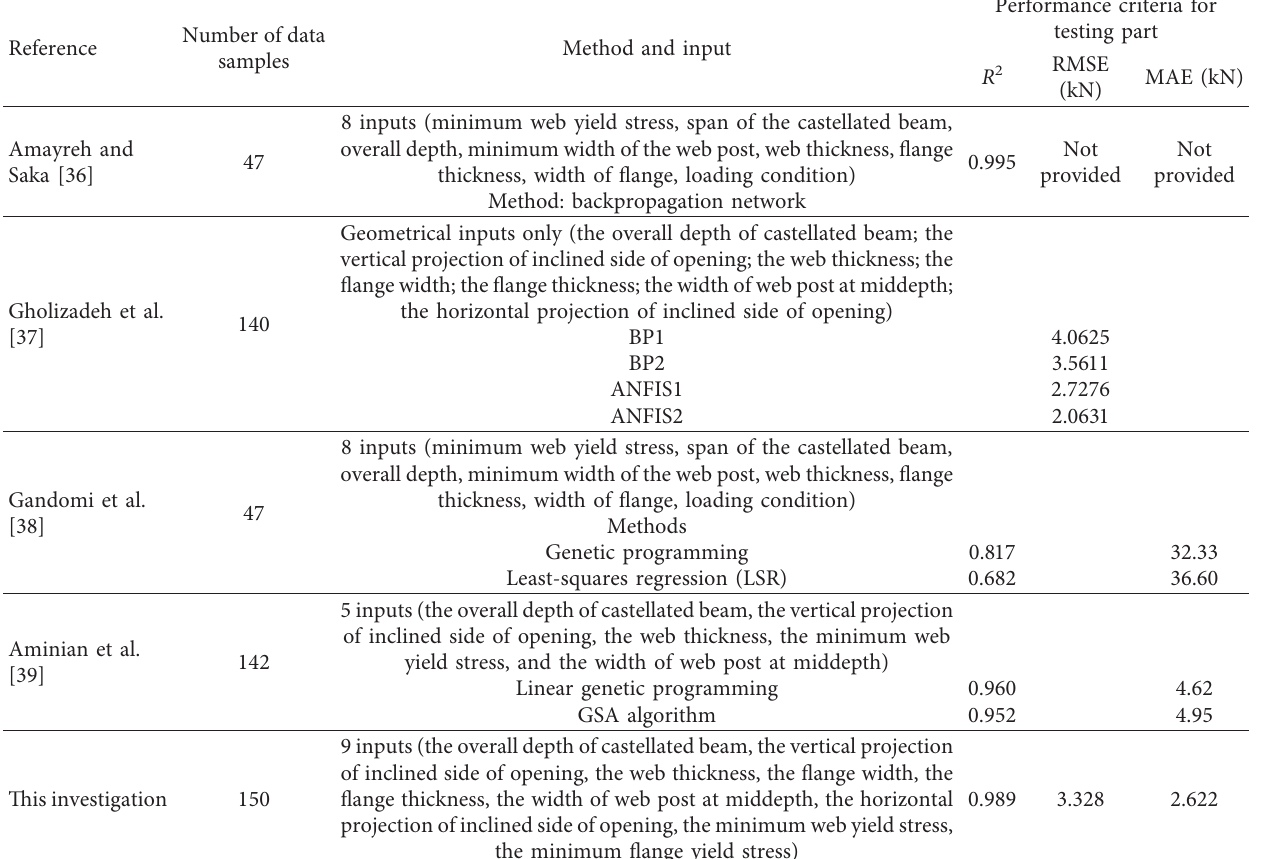
Table 3: Results comparison with currently popular AI